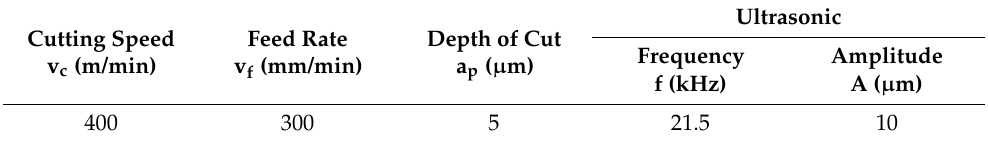
Table 1. Machining parameters used in the experiments.